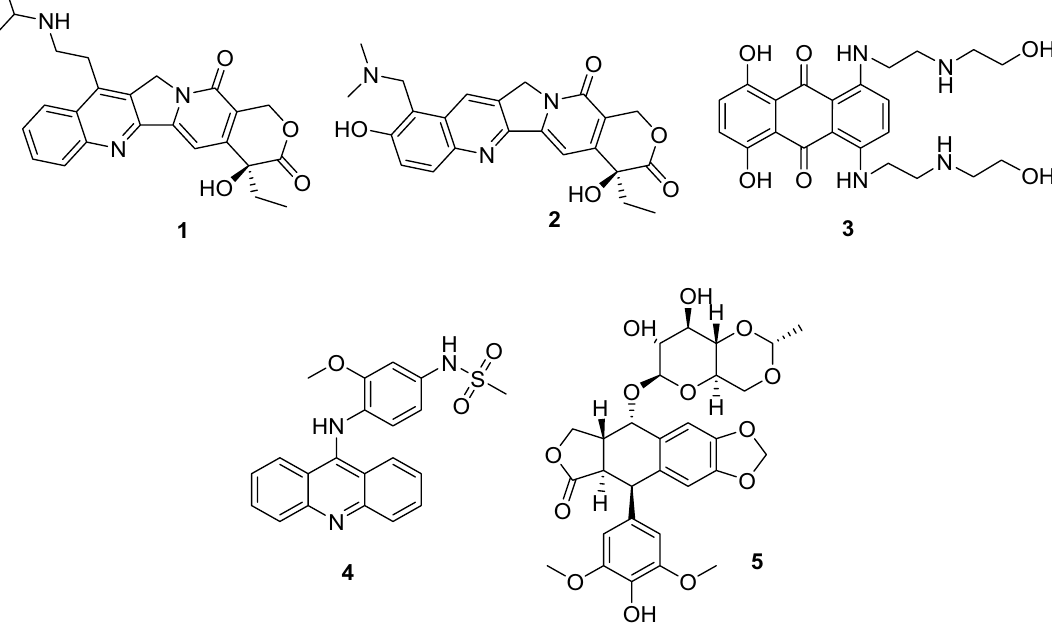
Figure 1. Chemical structures of selected clinically approved Topoisomerase I & II inhibitors ( 1–5 ).Generated using ChemDraw 2021 (https:// perki nelme rinfo rmati cs. com/ produ cts/ resea rch/ chemd raw) 19